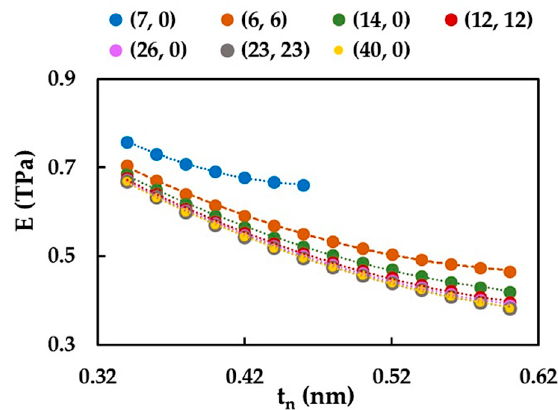
Figure 6. Evolutions of the Young’s modulus, E, with the NT wall thickness, t n for selected SWSiCNTs from Table 2.